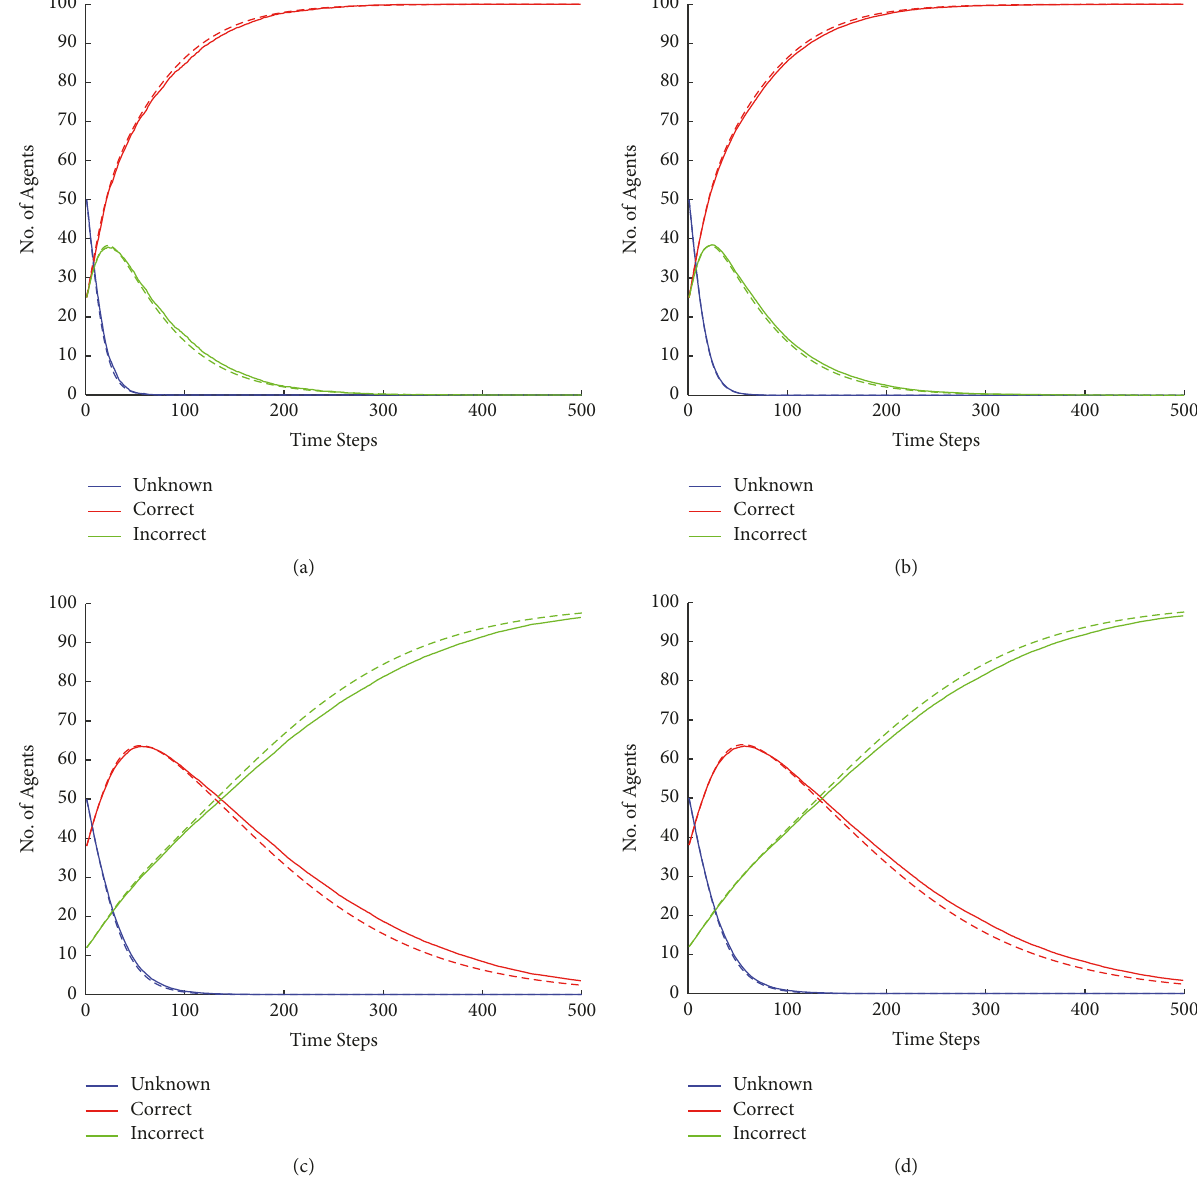
Figure 2: Comparison of original and proposed model with mean trust value of 0.5 and 100 population size. (a) Nominal scenario in existing model; (b) nominal scenario in proposed model; (c) wishful-thinking scenario in existing model; (d) wishful-thinking scenario in proposed